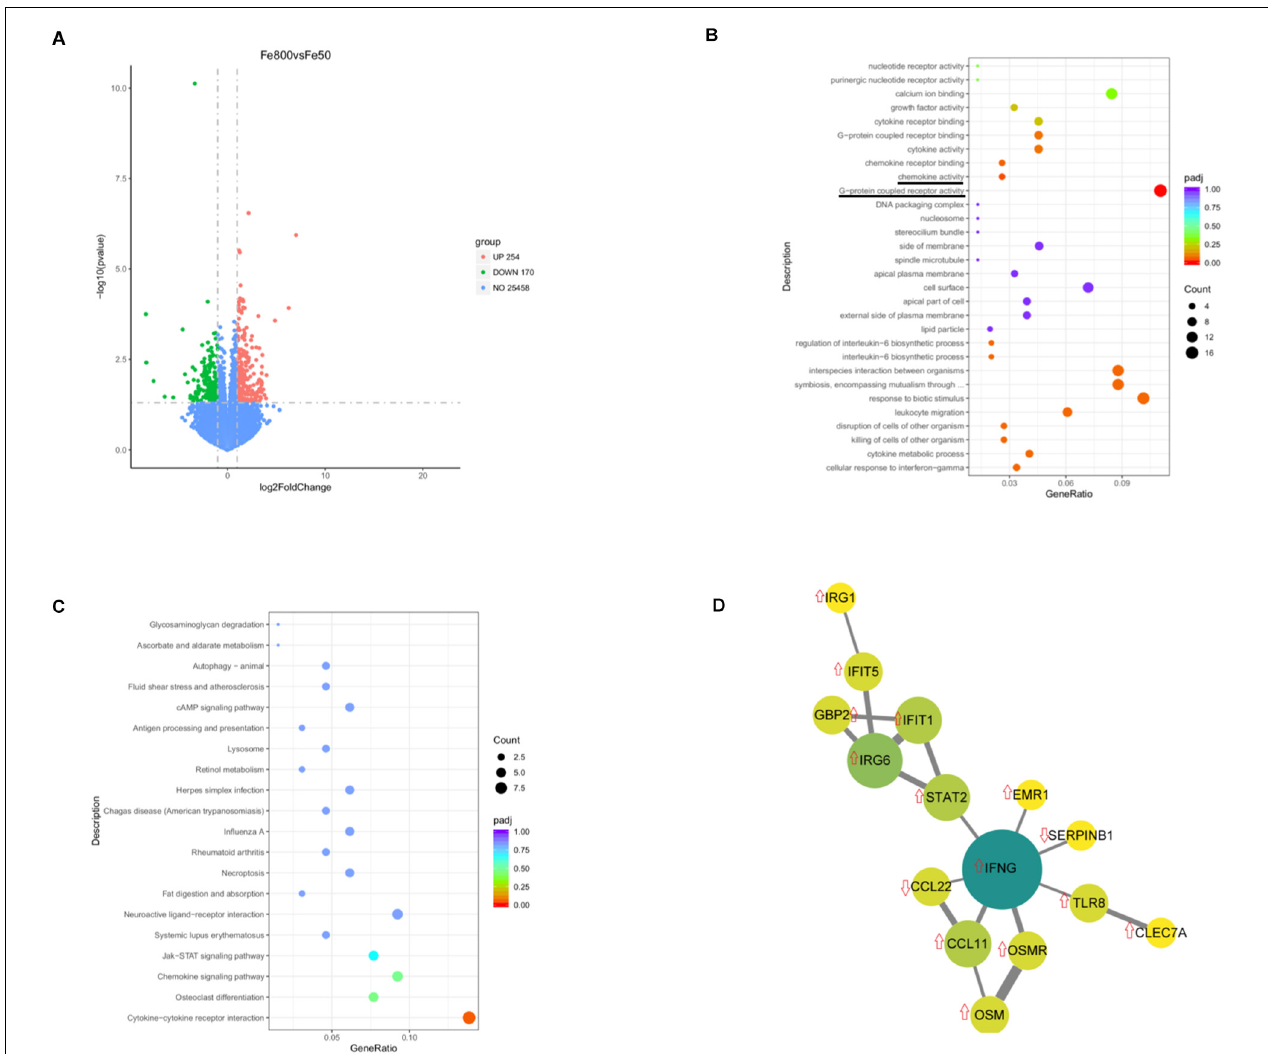
FIGURE 5 | Dietary iron changed colonic transcript profiles. Volcano diagram shows that more than 25,000 gene expressions were detected and quantitated and 424 genes were differential expression genes (DEGs), including 254 upregulated DEGs and 170 downregulated genes (A) . Gene Ontology (GO) enrichment analysis showed that G-protein-coupled receptor activity and chemokine activity were significantly enriched (B) , while Kyoto Encyclopedia of Genes and Genomes (KEGGs) enrichment analysis indicated that the cytokine–cytokine receptor interaction pathway was significantly enriched (C) . The largest connected component of the protein–protein interactions (PPIs) network is shown in (D) . Fe50 group ( n = 5) and Fe800 ( n = 5)